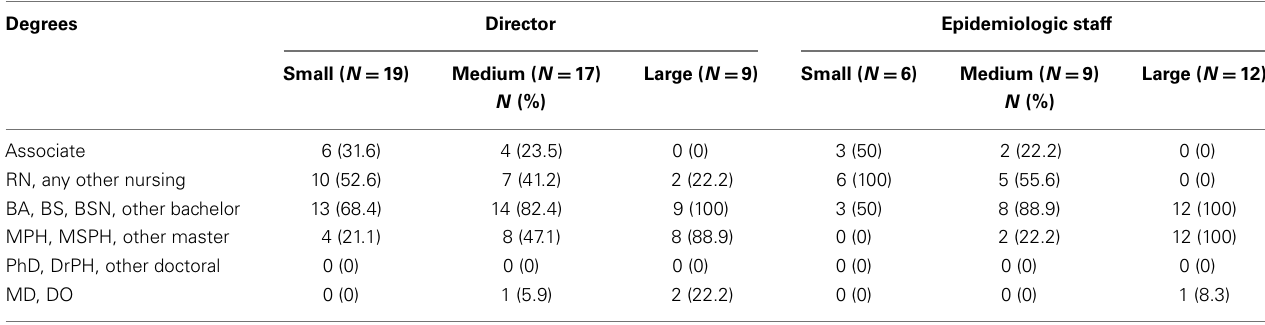
Table 1 |Average number of individuals performing epidemiologic functions within local health departments (LHDs) .